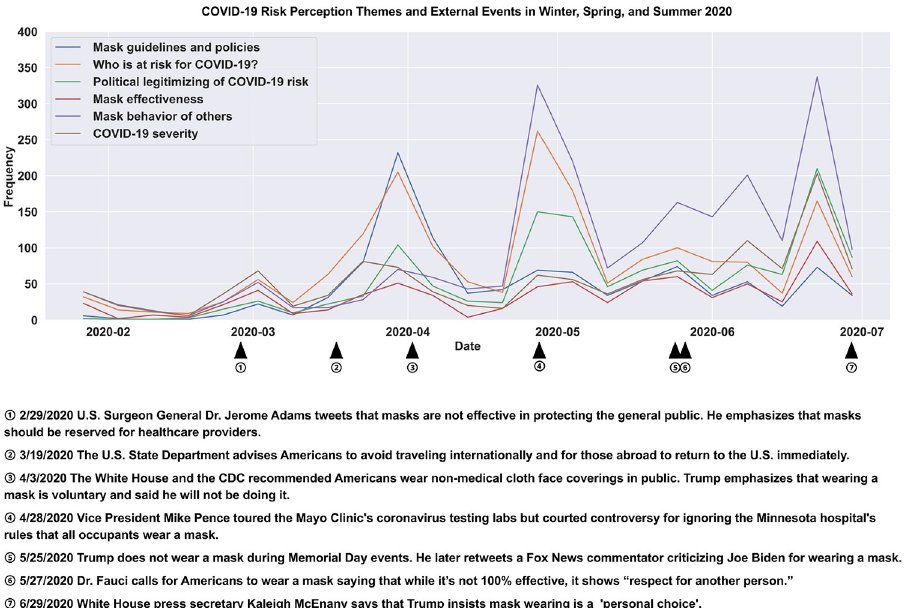
Fig 4. COVID-19 risk perception themes and external events in 2020. Data points are aggregated by 7-day periods (weeks). For each month in the graph, there are 4 data points. Each data point represents the frequency for a certain label during the past 7-day